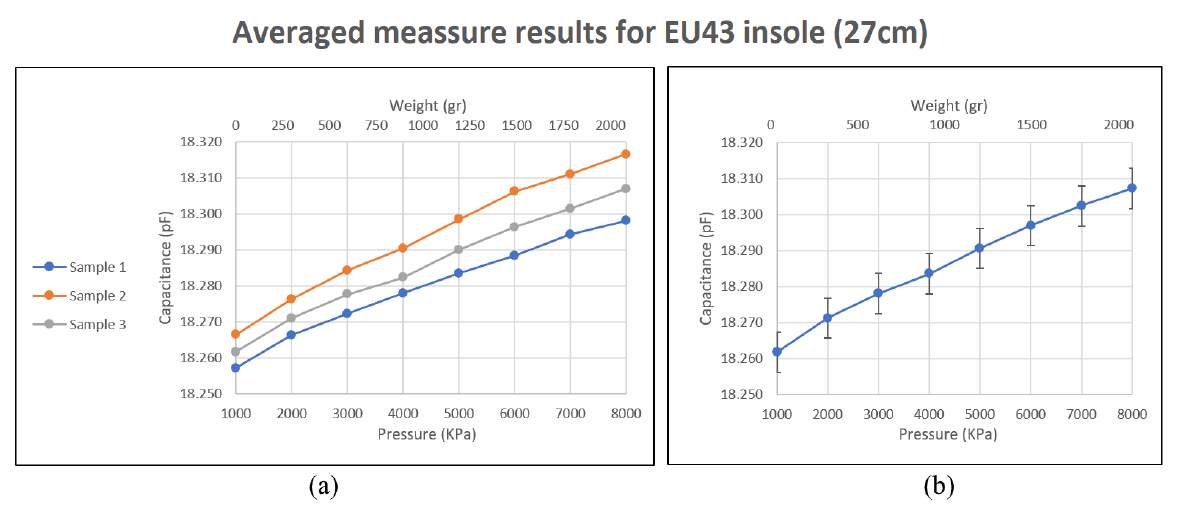
Figure 8. Behavior of sensors against weight in the area they occupy, Using higher loads. ( a ) show the average results for each repetition performed. ( b ) shows the combined average of all